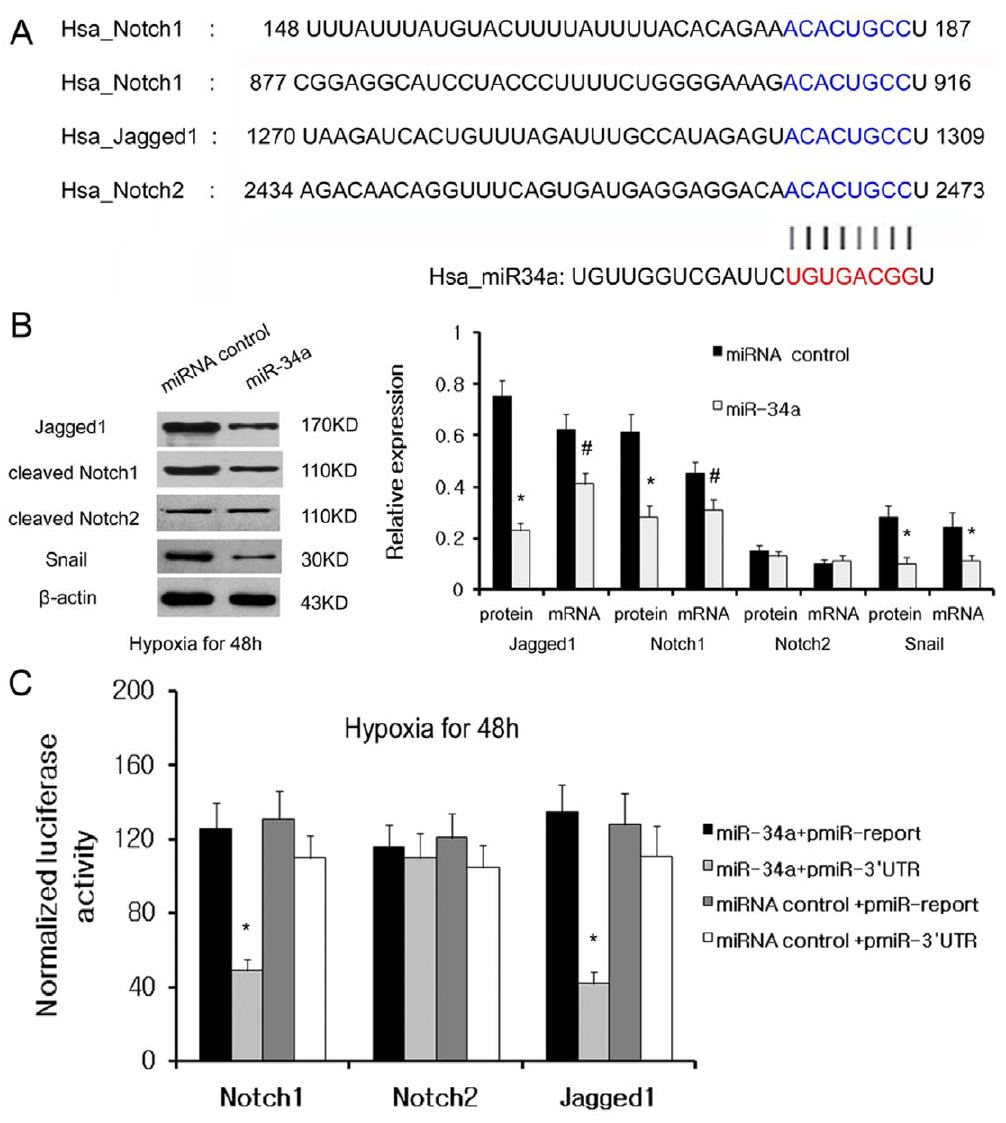
Figure 4. Notch1 and Jagged1 are directly regulated by miR-34a. (A) Putative binding sites of miR-34a in Notch1, Notch2 and Jagge1 3 9 UTR are shown with color letters. (B) Jagged1, Notch1, Notch2, Snail protein level and mRNA level were respectively detected by Western blotting and qRT- PCR 48 h after transfection with miR-34a precursor or precursor control in HK2 cells under low oxygen. A representative blot from three independent experiments is shown (left). The histogram shows the average volume density normalized to the b -actin (right). (C) Dual luciferase assay was performed in HK2 cells under hypoxia co-transfected with luciferase construct (pMIR-Norch1-3 9 UTR, pMIR-Norch2-3 9 UTR, pMIR-Jagged1-3 9 UTR or pMIR-report control) and miR-34a precursors or precursor control. Firefly luciferase activity was normalized to Renilla luciferase activity for each sample. The results shown represent the mean 6 SD from 3 independent experiments. # p , 0.05 and *p , 0.01 compared with empty vector or miRNA precursor control.